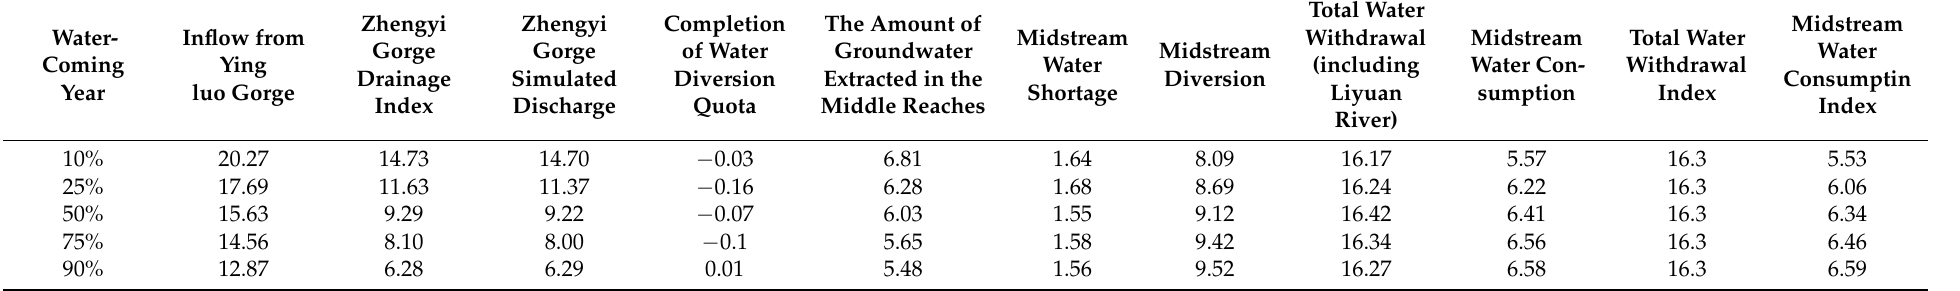
Table 7. The results of mid-stream water resources allocation under the condition of current water demand are considered, 10 8 m 3 .